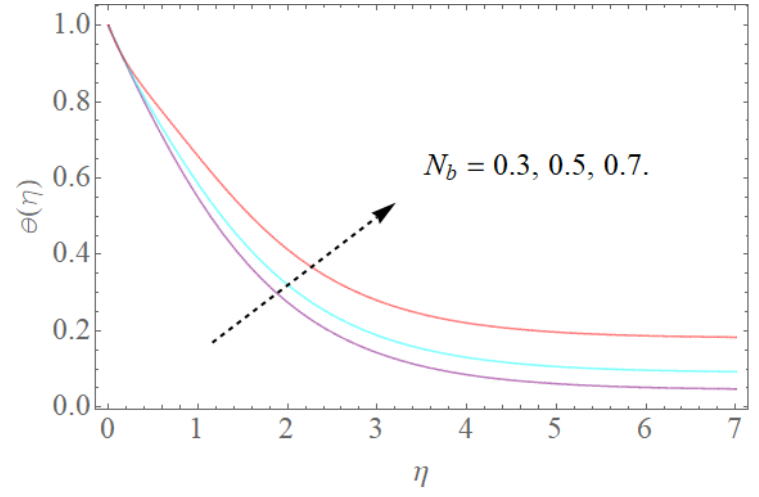
N on     when . Figure 12. The effect of N b on θ ( η ) when N t = 0.2, α = 1.0,Pr = 7.5, R = 0.8. Figure 12. The effect of b